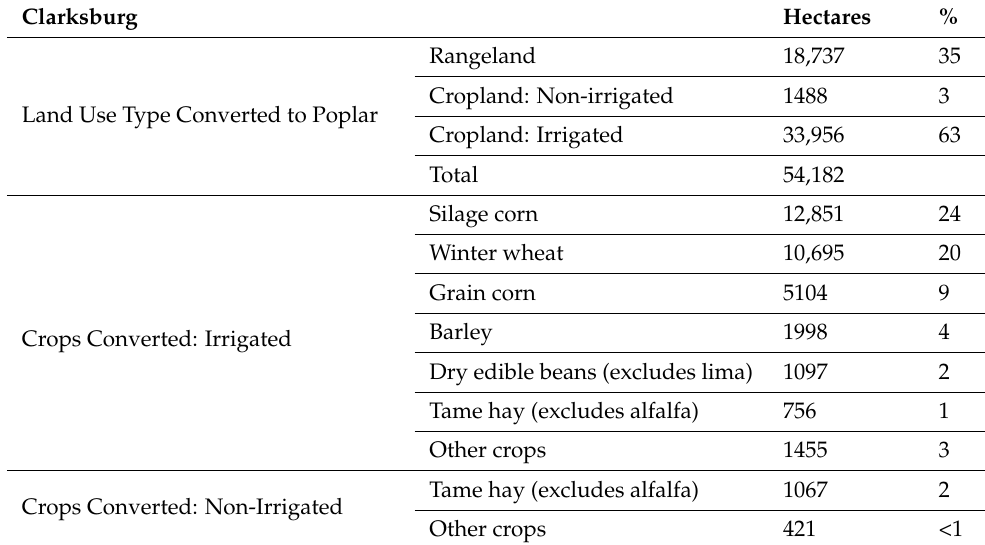
Table 5. Clarksburg land use and crop types converted to growing poplar. ‘Other crops’ are crops that individually represented less than 1% of the land used to grow crops. Percentage column is based on total land use types converted to growing